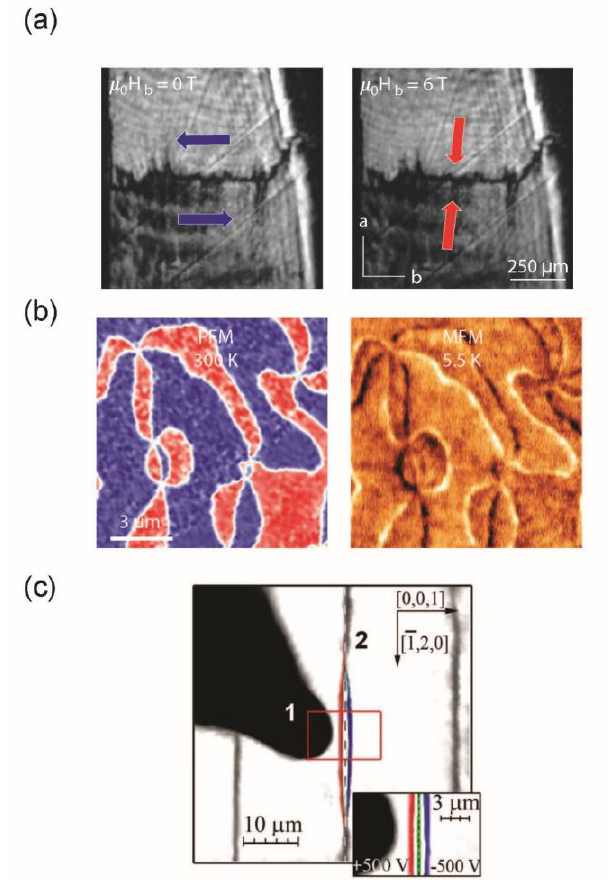
Figure 3. Spin-driven ferroelectric domain wall manipulation ( a ): Spatially resolved SHG images at 0 and 6 T show the magnetic field-induced 90° polarization flop in doped MnWO 4 without a domain pattern change leading to nominally charged domain walls. The blue and red arrows in each image indicate the polarization direction [140]. Magnetic moment at antiferromagnetic/ferroelectric domain walls ( b ): Room temperature PFM and low-temperature MFM (5.5 K, 0.1 T) measurements on h-ErMnO 3 [141]. Finite polarization at ferromagnetic Neel domains ( c ): Magneto-optical images of domain walls (2) in iron garnet films influenced by a voltage applied to a tip electrode; (1). Depending on the sign of the voltage, the domain wall is either attracted (red marked domain wall position) or repelled (blue marked domain wall position) from the electrode (3). The green line indicates the original position of the domain wall [142].